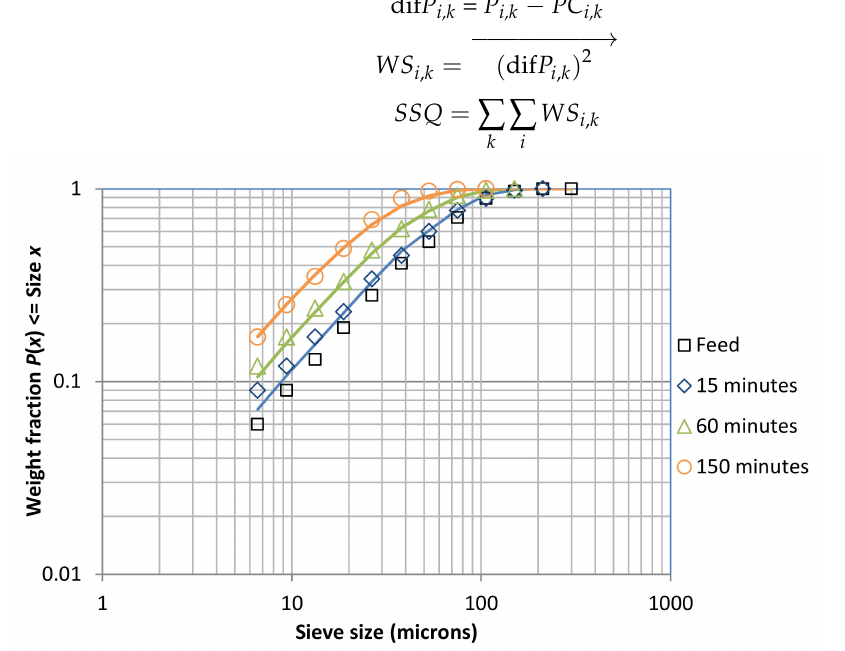
Figure 6. Product size distributions at grinding times 0 (feed), 15, 60 and 150 min; symbols are experimental data, lines the model values ( a = 7.6 × 10 − 5 min − 1 , α = 1.27, Run